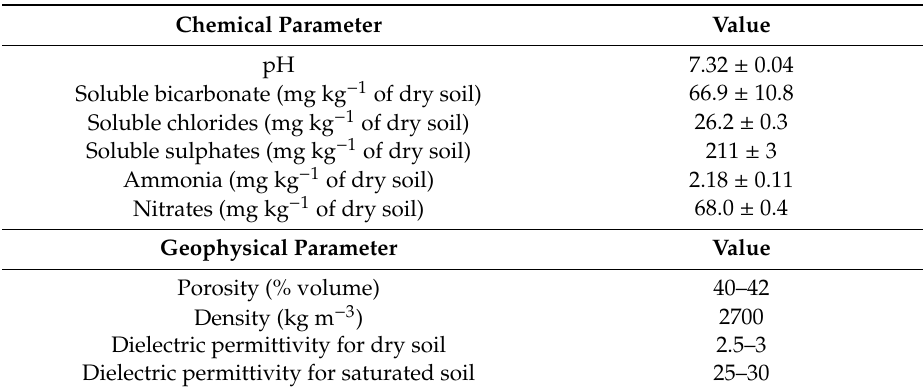
Table 1. Chemical and geophysical soil